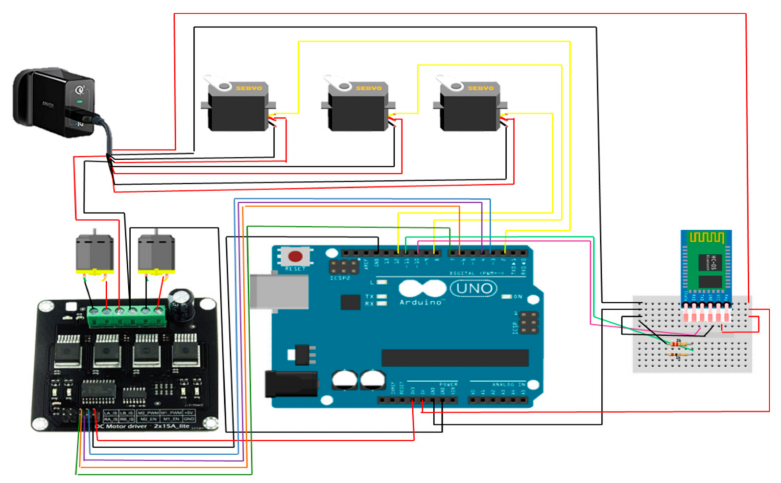
Figure 3. System connections